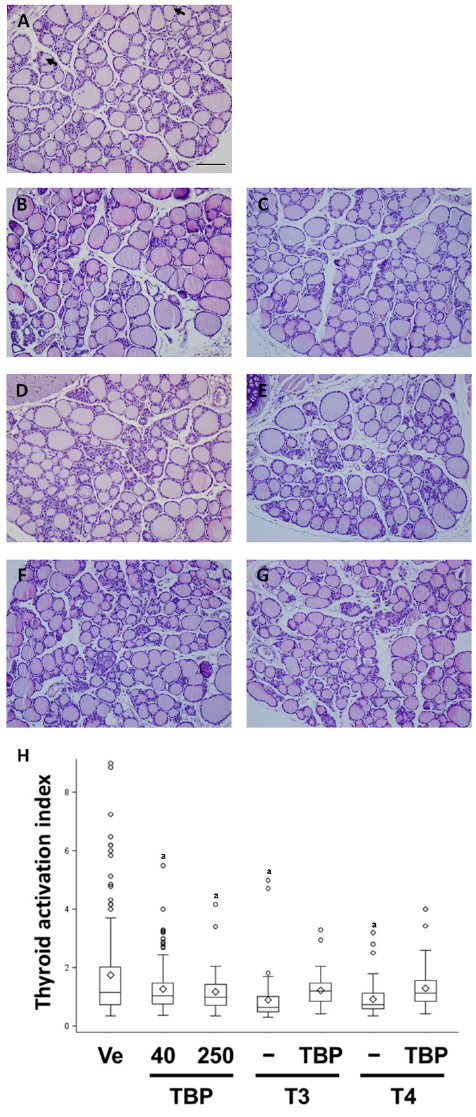
Figure 3. Thyroid gland histology (( A ) Ve; ( B ) TBP 40; ( C ) TBP 250; ( D ) T3; ( E ) TBP-T3; ( F ) T4; ( G ) TBP-T4) and thyroid gland activation index ( H ). Arrow indicates resorption lacunae of follicle. Each thyroid gland was pictured at 200× magnification. Scale bar represents 100 μ m. Results presented